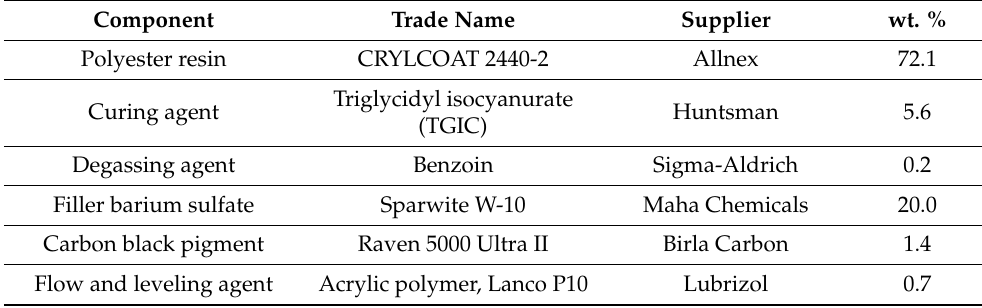
Table 2. Formula 2—black polyester/TGIC powder